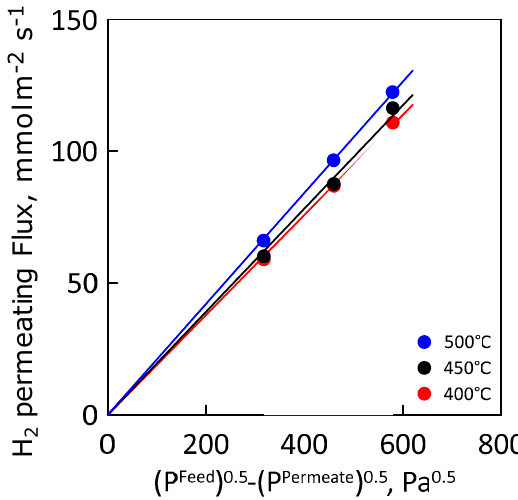
Figure 10. Hydrogen flux as a function of Sieverts’ driving force at different temperatures.